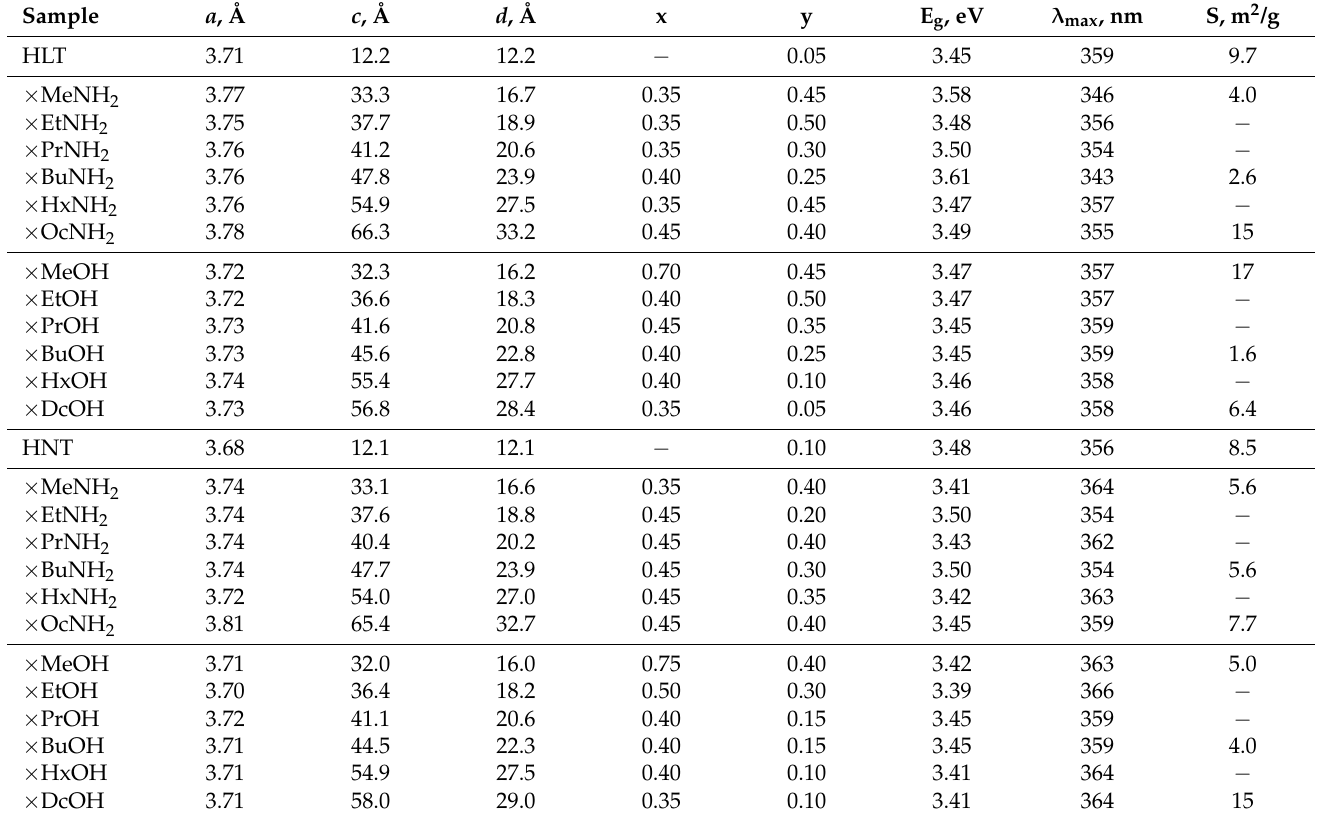
Table 1. Lattice parameters in the tetragonal system, interlayer distances d , organic (x) and water (y) content per formula unit, light absorption edges and specific surface areas of the initial titanates and their inorganic–organic derivatives. Compositions of the n -alkylamine and n -alkoxy derivatives